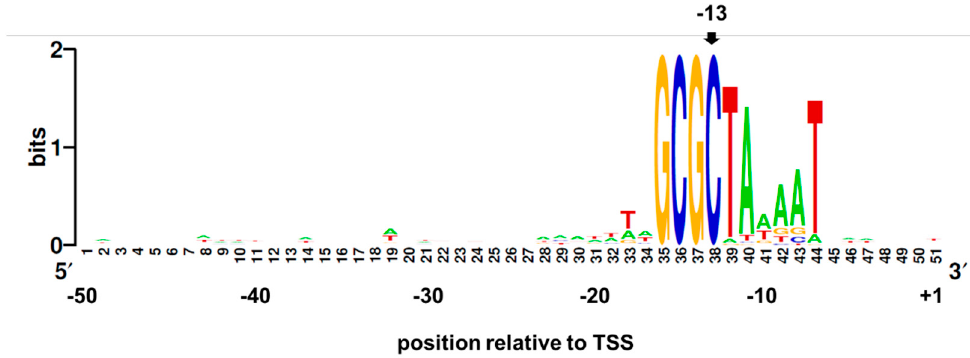
Figure 2. Conservation of H. pylori 26695 promoters with a GCGC motif near position − 13. Promoter sequences were inferred from the TSS database reported by Sharma and co-workers [31]. The 3 ′ - ends of the GCGC motifs in the promoters were positioned from − 11 to − 15 relative to the TSS, with − 13 being the most common position. The GCGC motifs were aligned for 79 promoter sequences and from the alignment a sequence logo was generated using WebLogo (https://weblogo.berke-